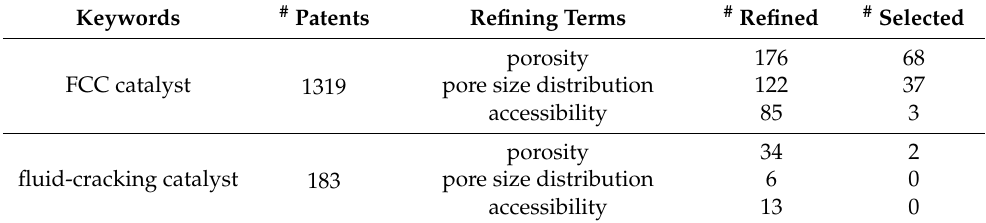
Table 3. Patent search results in the USPTO platform.